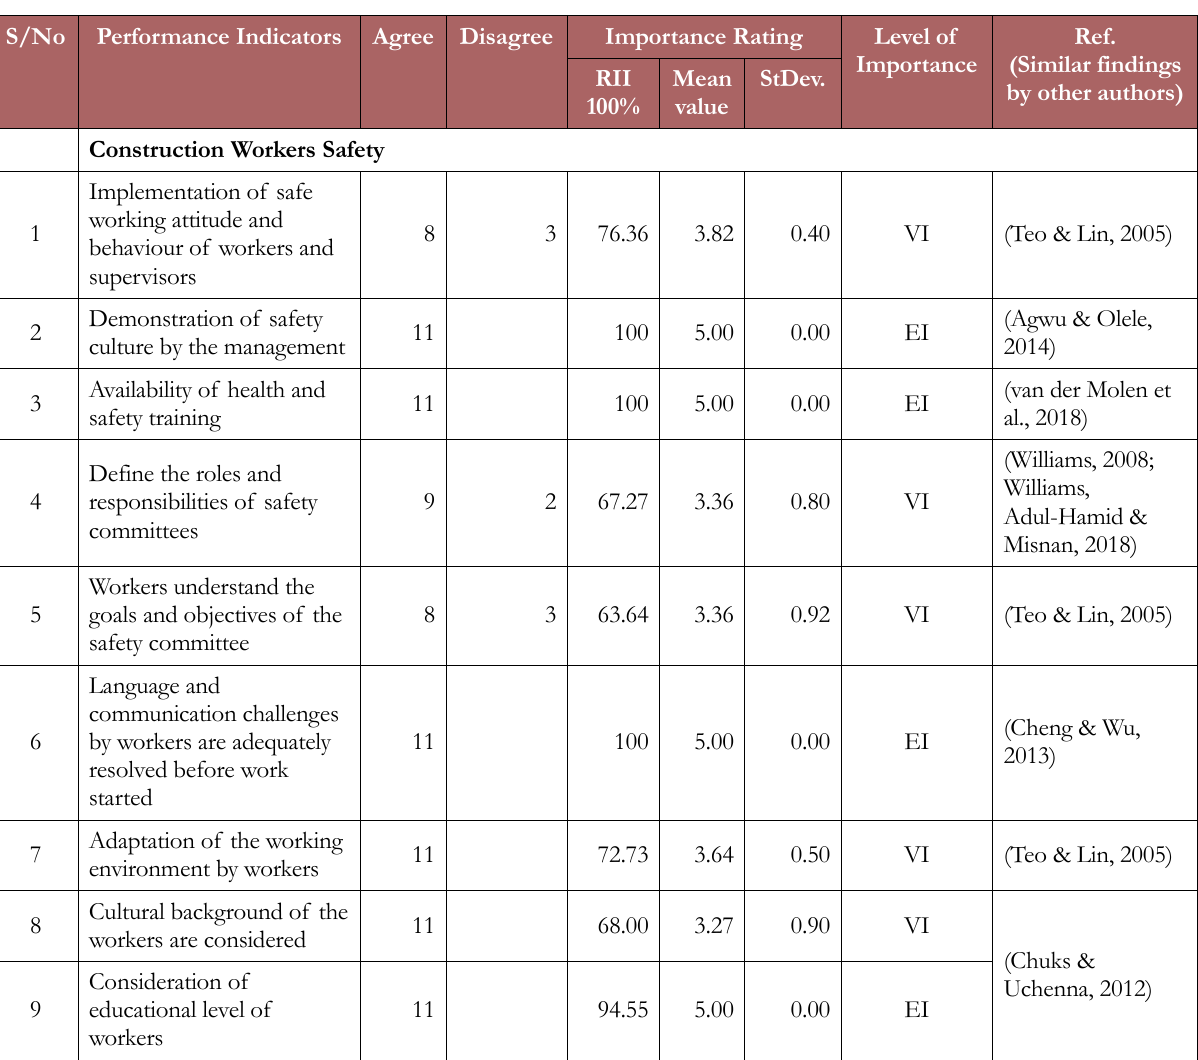
Table 5. Key Performance Indicators for Construction Safety